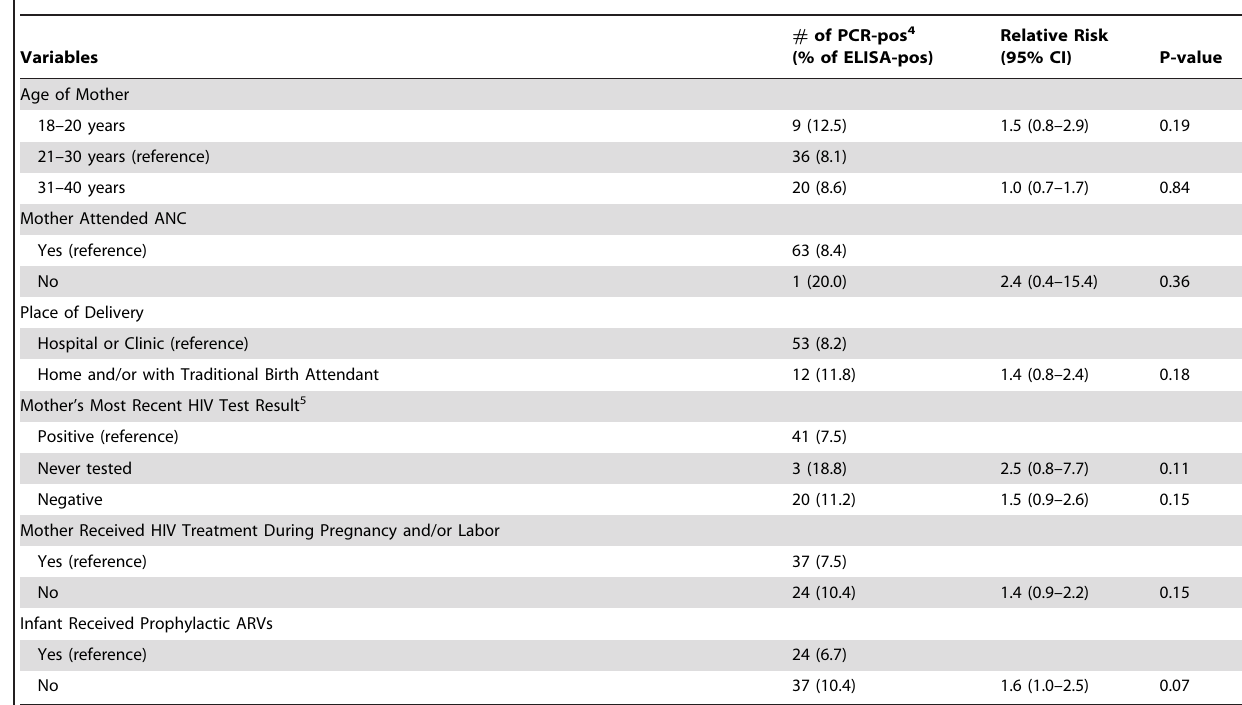
Table 4. Relative Risk of HIV Transmission by Risk Factor Among ELISA Positive Infants.